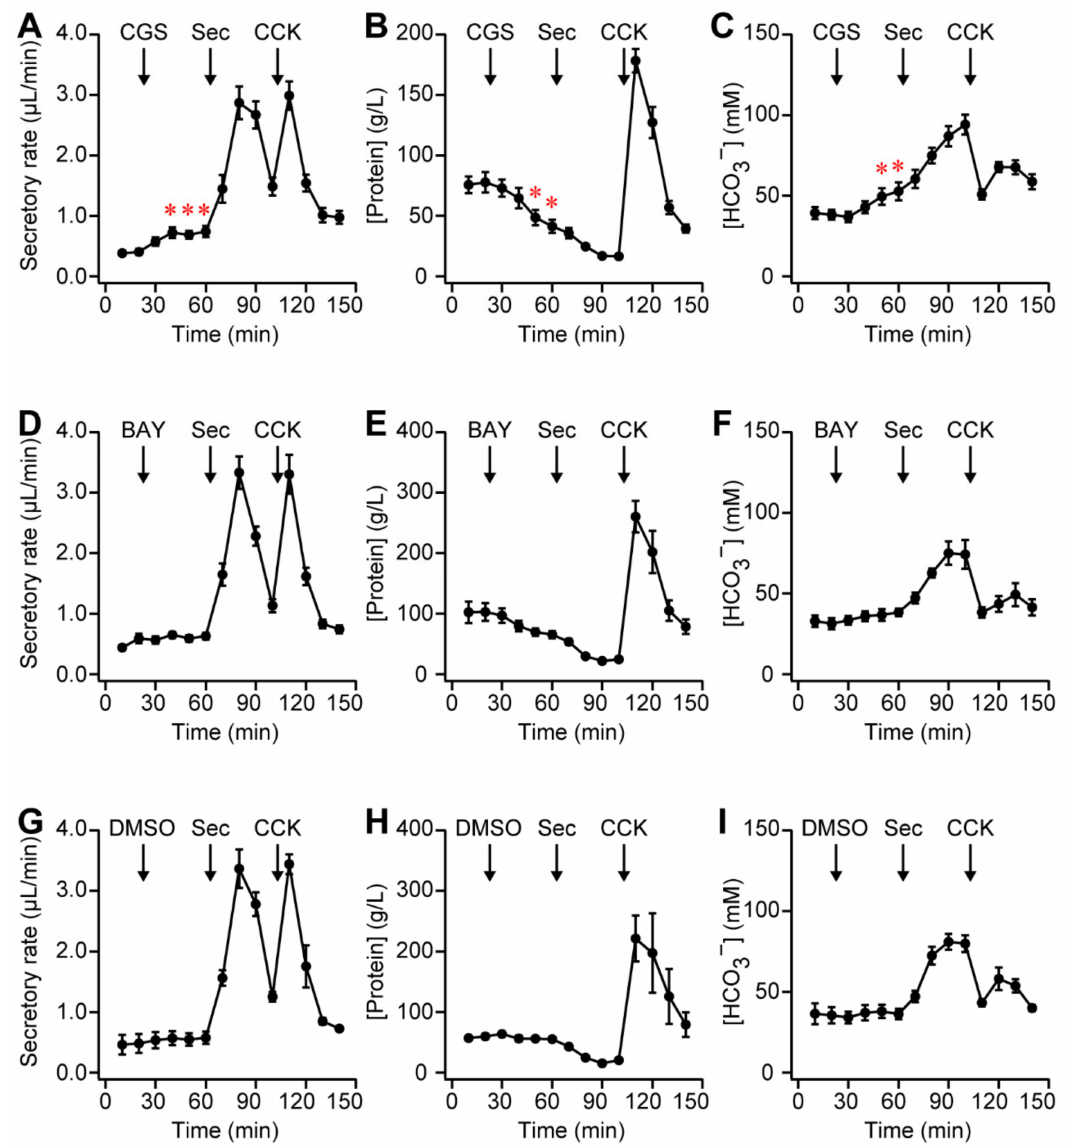
Figure 6. ( A ) Time-course of secretory rate of pancreatic juice from the anesthetized rats, which were intravenously injected with 4-[2-[[6-Amino-9-( N -ethyl- β -D-ribofuranuronamidosyl)-9 H -purin-2-yl]amino] ethyl]benzenepropanoic acid (CGS 21680; CGS, 20 nmol / kg body weight), secretin (Sec, 0.1 nmol / kg body weight), and cholecystokinin (CCK, 0.3 nmol / kg body weight), as indicated by arrows ( n = 6 rats, * p < 0.05). Values were compared with the control value at 20 min. Pancreatic juice was collected in a silicone tube. Sample volumes were determined by the length of pancreatic juice in the silicone tube. The concentrations of protein ( B ) and HCO 3 − ( C ) in pancreatic juice. ( D – F ) Time-courses of experiments in the anesthetized rats, which were intravenously injected with 2-({6-Amino-3,5-dicyano-4-[4-(cyclopropylmethoxy)phenyl]pyridin-2-yl}sulfanyl)acetamide (BAY 60-6583; BAY, 20 nmol / kg body weight), secretin, and cholecystokinin ( n = 5 rats). ( G – I ) Time-courses of experiments in the anesthetized rats, which were intravenously injected with vehicle control (0.4% DMSO in saline, 1 mL / kg body weight), secretin, and cholecystokinin ( n = 3 rats). Secretin increased the secretory rate ( A , D ) and HCO 3 − concentration in pancreatic juice ( C , F ), indicating ductal secretion. Cholecystokinin increased the secretory rate and protein concentration ( B , E ), indicating acinar